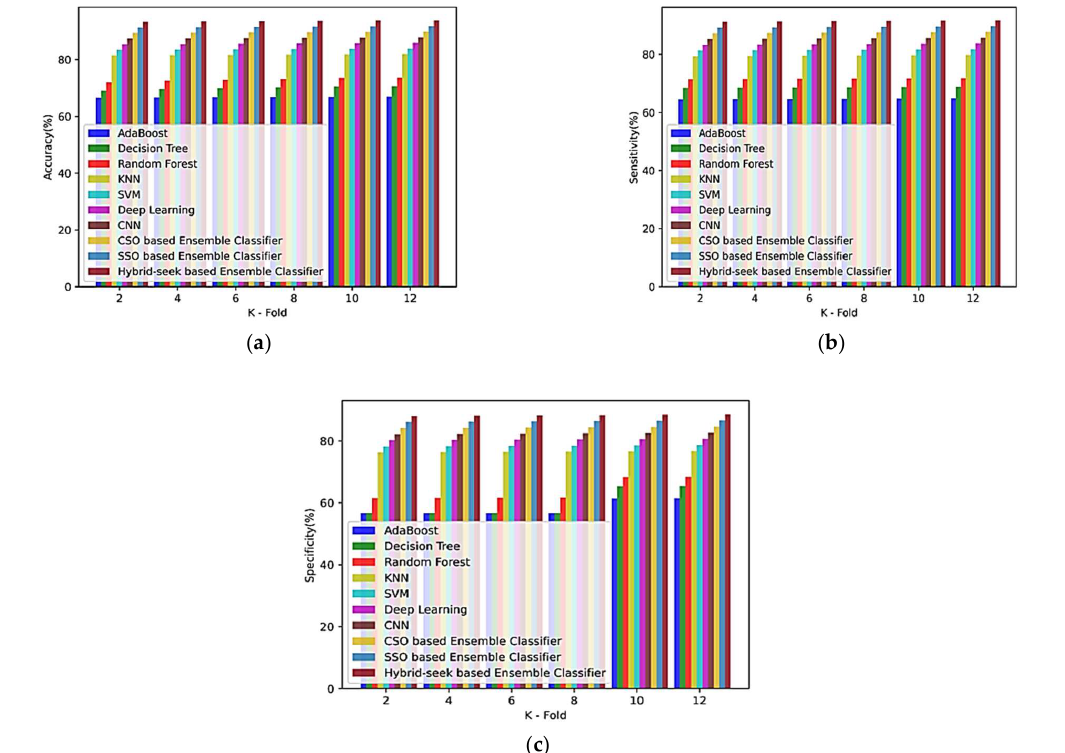
Figure 9. Comparison of k-fold values of the CHB-MIT database with other classifiers for ( a ) accuracy, ( b ) sensitivity, and ( c ) specificity.